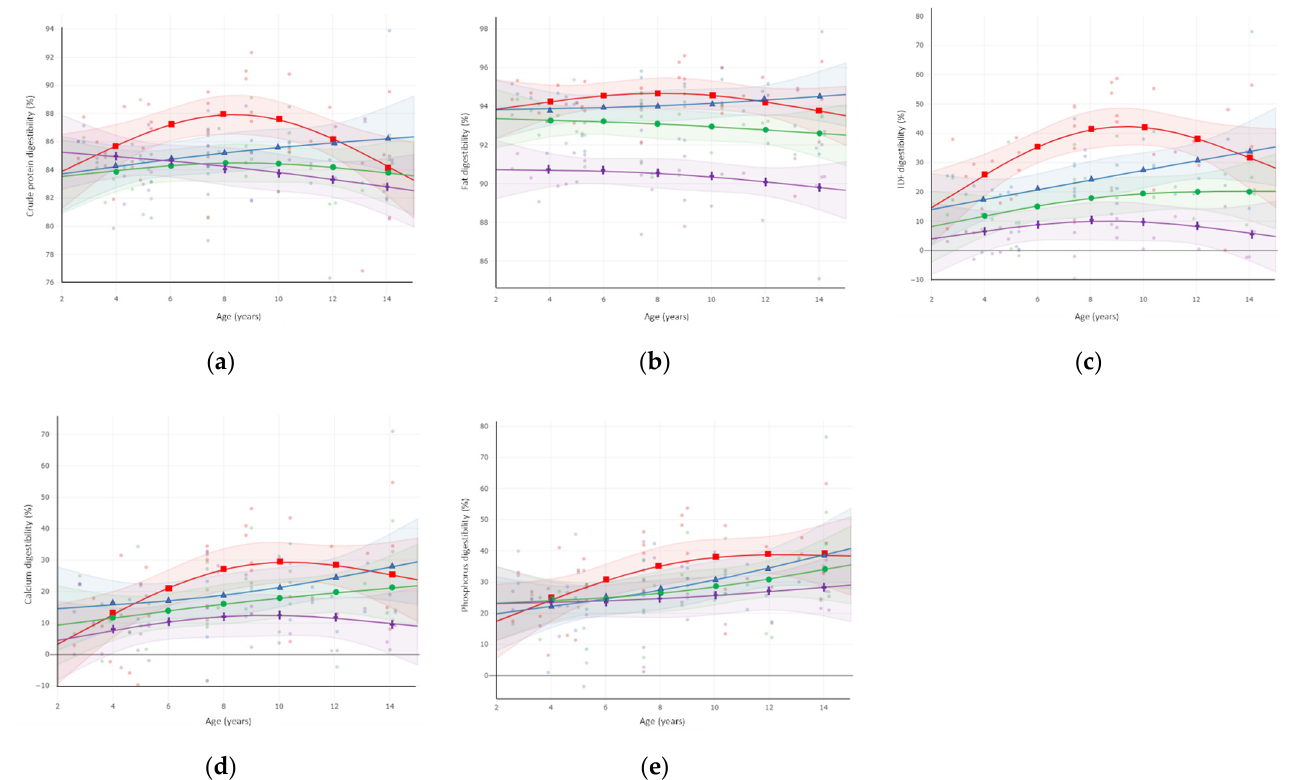
Figure 2. Apparent digestibility (%) of ( a ) crude protein; ( b ) fat; ( c ) total dietary fibre (TDF); ( d ) calcium; ( e ) phosphorus as a function of age in dogs fed the Low-Fibre (red line; square), Medium-Fibre (blue line; triangle), High-Fibre (green line; circle), and Very-High-Fibre (purple line; cross) diets. Shaded areas denote 95% confidence intervals.